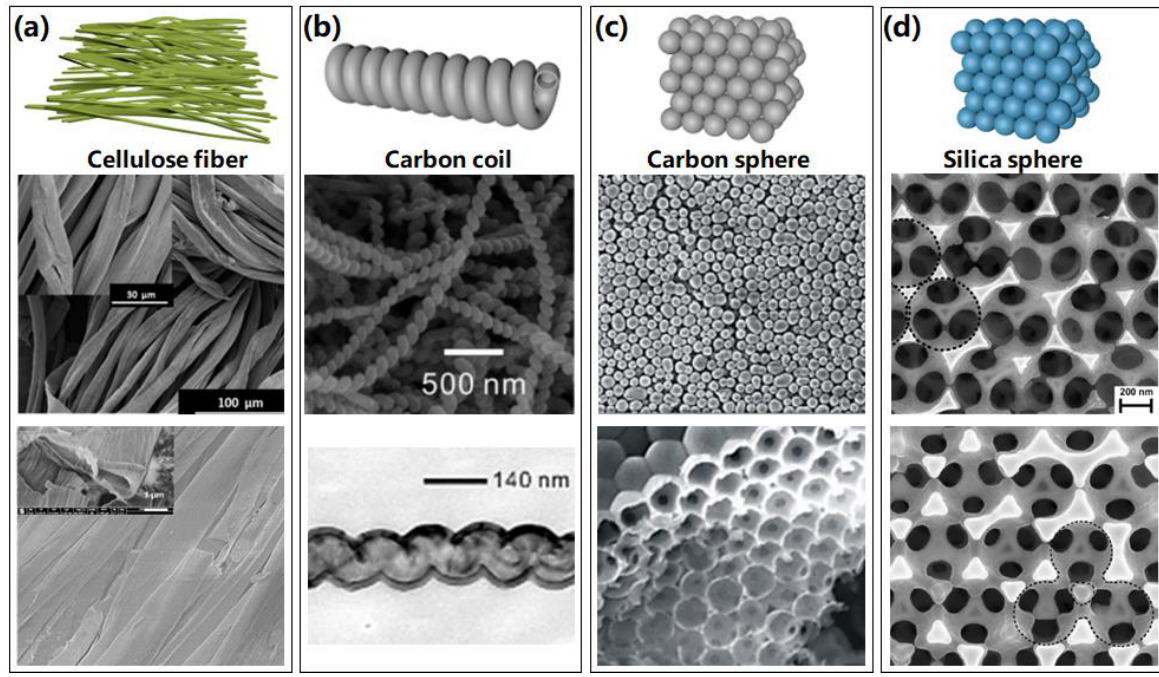
Figure 6. Several special 3D nanostructures fabricated by atomic layer assembly method through cellulose, carbon, and silica templates. ( a ) Schematic images of cellulose fiber templates, SEM images of TiO 2 fibers on cellulose fibers, and SEM images of Al 2 O 3 nanofibers after cellulose extraction.